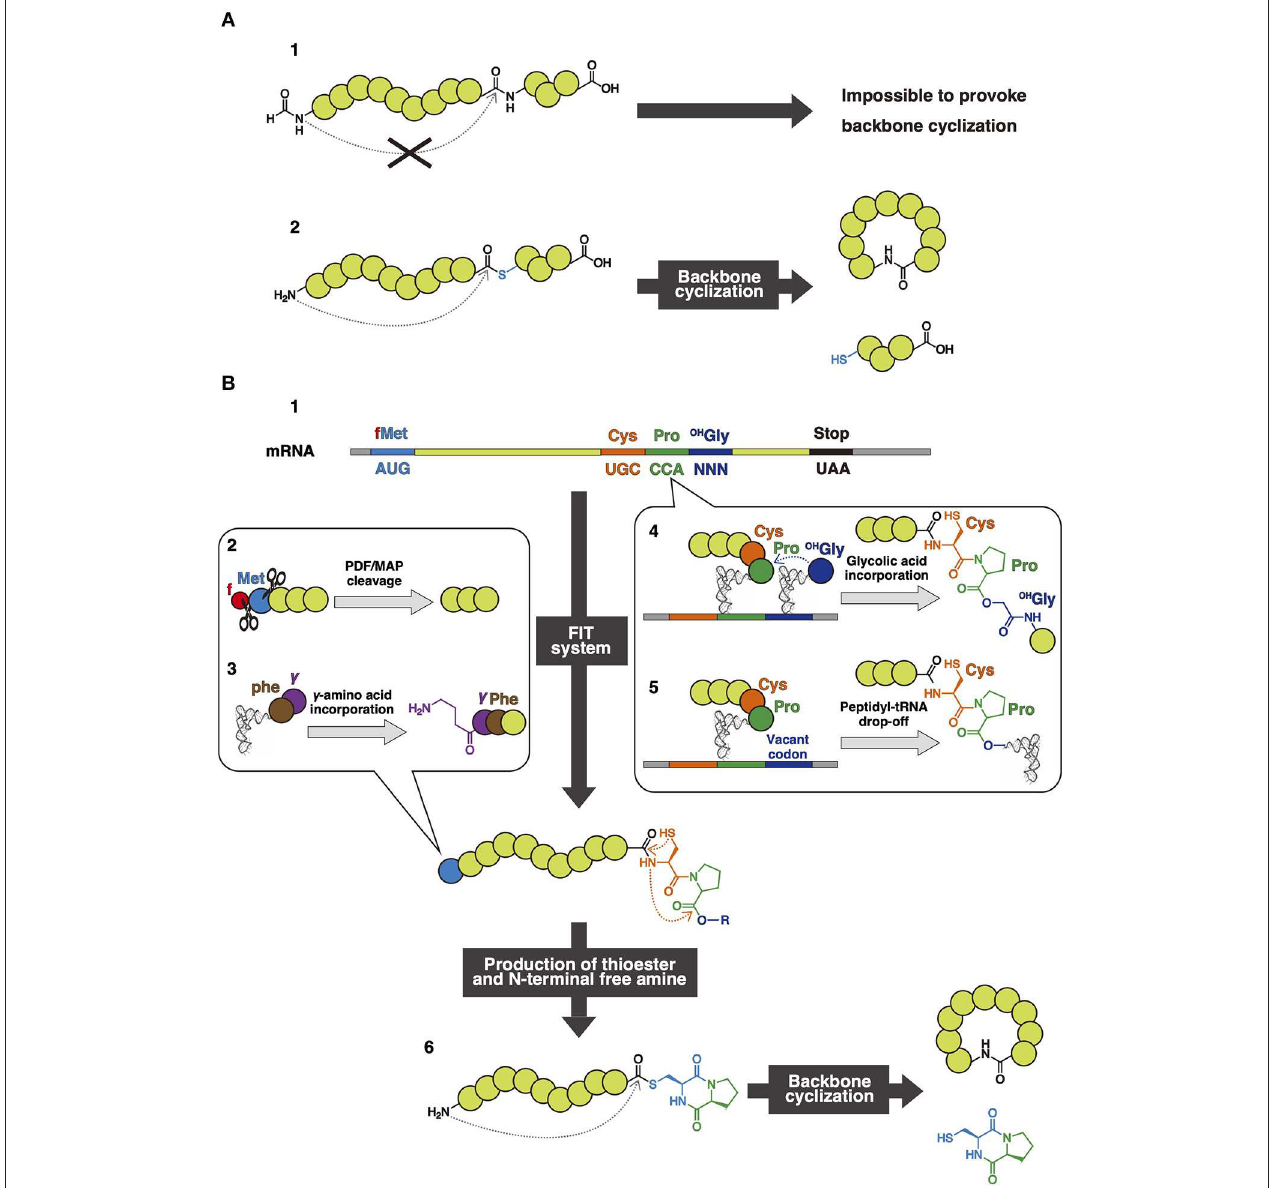
FIGURE 9 | (A) General thioester activated backbone cyclization. A general translated peptide (1). A peptide containing N-terminal free amine and thioester to provoke backbone cyclization (2). (B) Dkp-thioester activated backbone cyclization. An mRNA sequence to perform dkp-thioester activated backbone cyclization (1). PDF/MAP cleavage for the production of free amine (2). Initiation codon reprogramming for expression of dipeptides containing γ -amino acid (3). The generation of an ester bond in the nascent peptide chain with expression of Cys, Pro, and OH Gly (4), or Peptidyl-tRNA drop-off (5). Dkp-thioester activated backbone cyclization